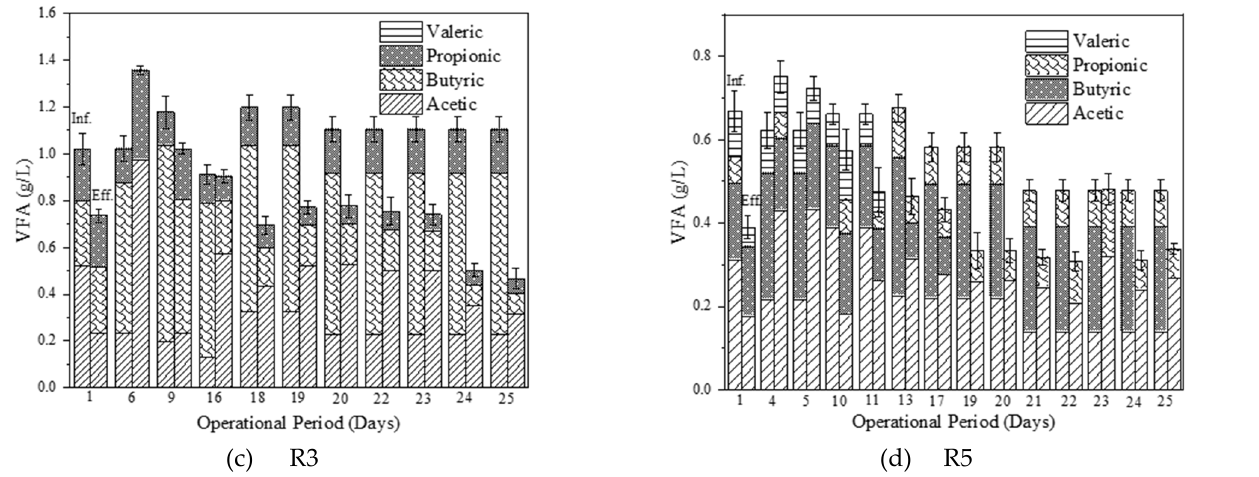
Figure 1. The VFA consumption profiles for ( a ) R7, ( b ) R16, ( c ) R3, and ( d ) R5 with individual VFA concentration in influent and effluent samples.